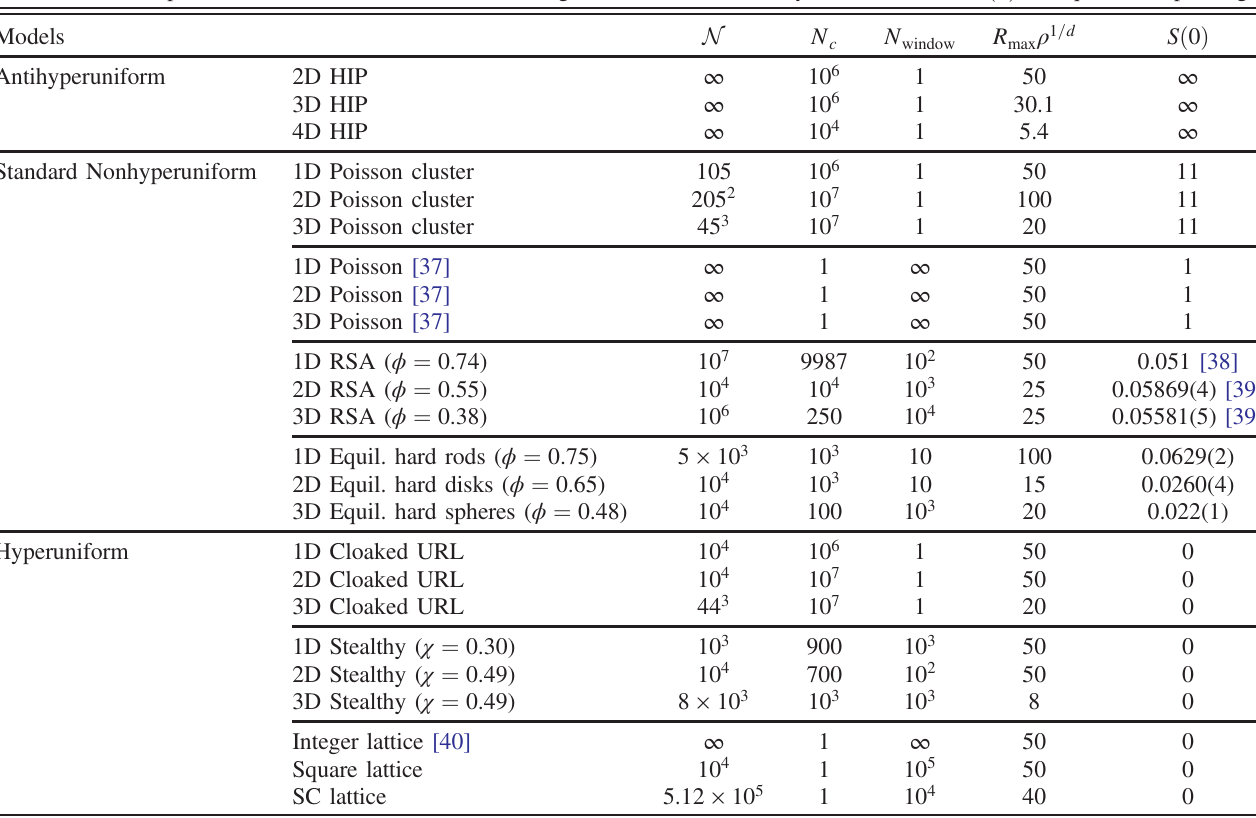
TABLE I. Simulation parameters for all of the model point processes across the first three space dimensions considered in this work. is the number of point patterns considered, N is the number Here, N is the average number of points inside a fundamental cell, N c window of observation windows per point pattern, and R is the largest radius of an observation window. We have also indicated the values of max the structure factors at the origin, S ð 0 Þ . In the case of equilibrium packings, the values of S ð 0 Þ are obtained from the exact result for hard r Þ in the limit r → ∞ [35,36]. rods ( d ¼ 1 ) [34] and highly accurate approximations for the conditional nearest-neighbor function G P ð Note that our computer simulation results are in excellent agreement with these analytical estimates of S ð 0 Þ for equilibrium packings. Models